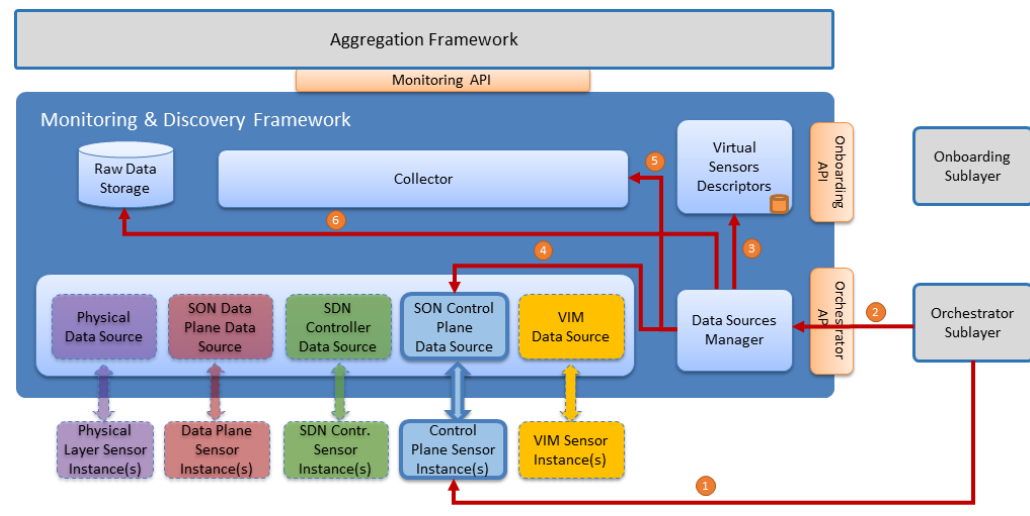
Figure 9. Sensor Instantiation Workflow.